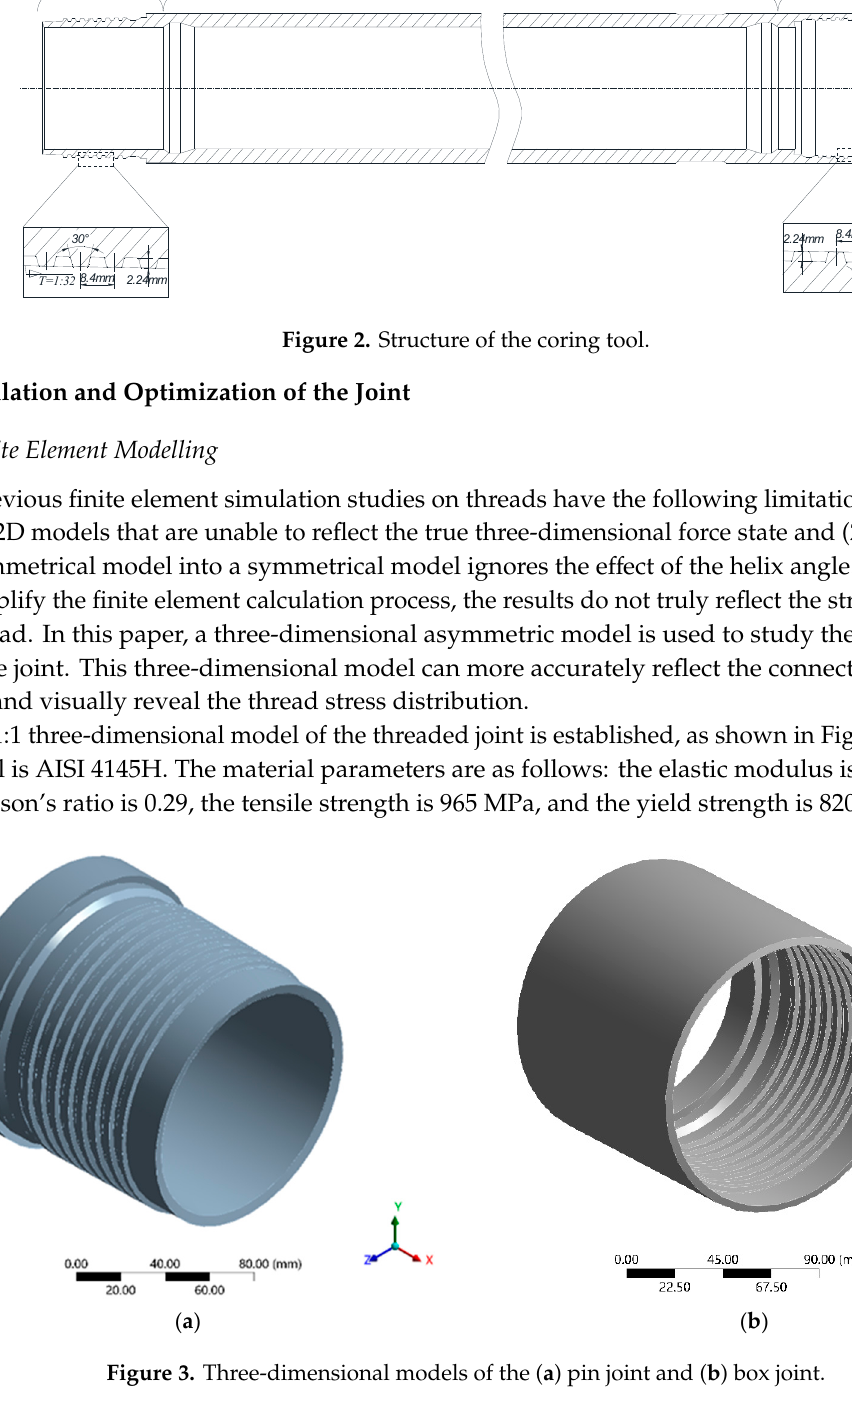
T = 1 :1 6 Figure 1. Schematic diagram of the thread profile. The structural parameters of the conical thread include the taper T , pitch p , lead S , helix angle θ , thread angle α , and thread height h . The taper is the ratio of the difference between the diameters of the large end and small end to the length of the thread. A tapered thread can produce a tight fit between threads. Therefore, a tapered thread has a good sealing capacity and good pressure capacity. The pitch refers to the axial distance between two adjacent threads. The strength of the thread increases as the pitch increases, but the self-locking effect decreases as the pitch increases. The lead is the axial distance at which a point on the thread is rotated 360 degrees along the helix. In a single-helix thread, the lead is equal to the pitch. The thread of a drilling joint is generally a single-helix thread. The helix angle is the angle between the tangent of the helix and the plane of the vertical helix axis. The helix angle determines the number of turns of the thread. The smaller the helix angle is, the greater the number of turns in the same distance and the better the self-locking effect of the thread. The thread angle is the angle between the two faces of the thread profile. The smaller the thread angle is, the larger the required upper buckle torque, and the easier it is for the thread to loosen. However, if the thread angle is too large, the thread strength will decrease, and the buckle torque will decrease. The thread height is the difference between the large diameter and the small diameter of the thread. When the thread height is too small, thread tripping can easily occur, and the stress in the thread is concentrated. When the thread height is too large, it is easy for the thread to buckle and break. 2.2. Design of the Joint